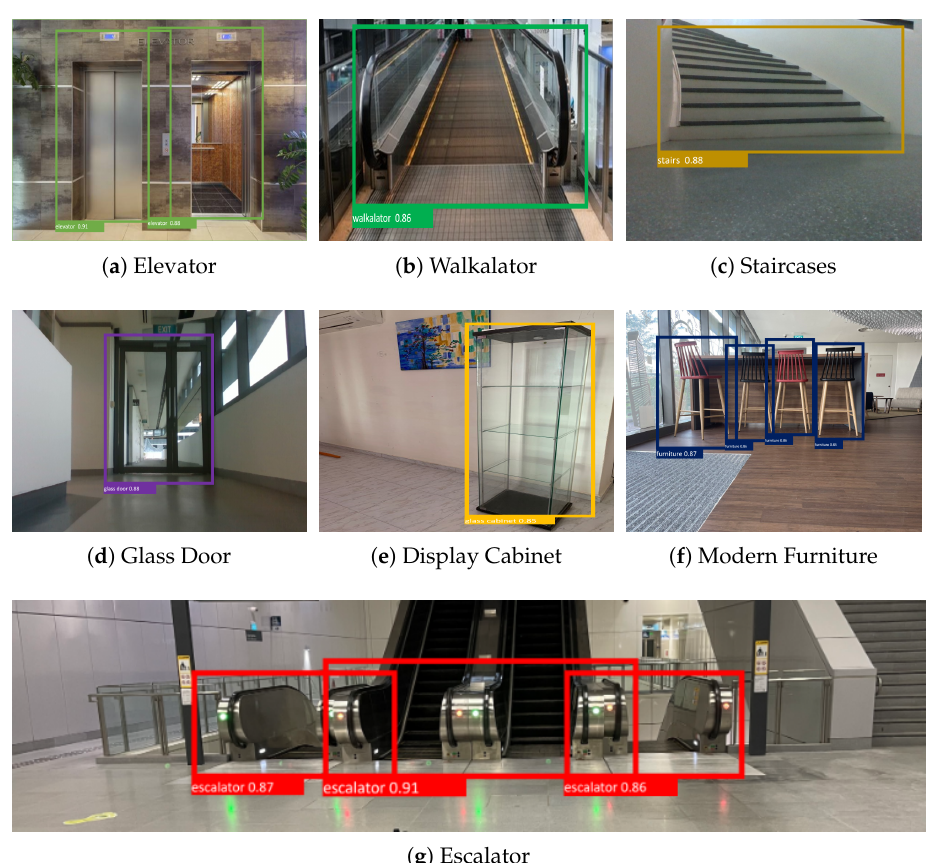
Figure 3. Experiment results of hazardous object